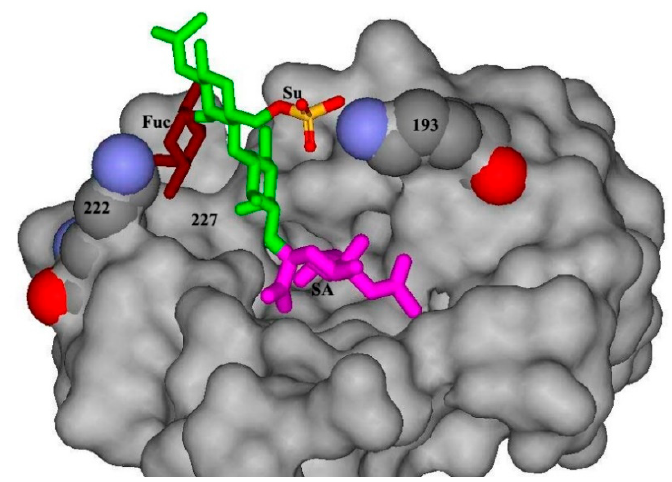
Figure 1. Molecular model of H5 HA complexed with sialyoligosaccharide Su-SLe x . Receptor specificity is not the only factor associated with the host range of the virus.